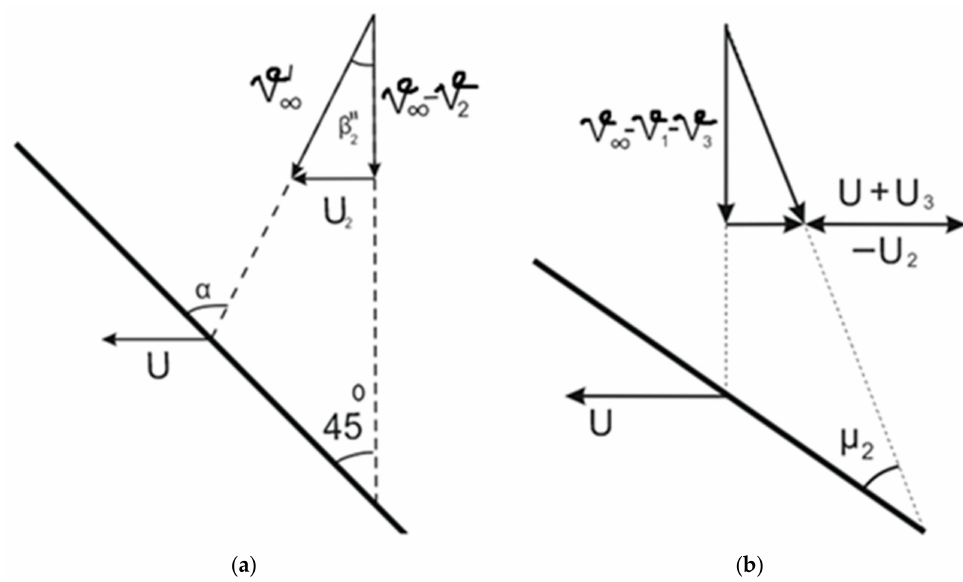
Figure 10. Absolute ( a ) and relative ( b ) velocities of the flow incident on the 2nd plate. The absolute velocity ϑ (cid:48) ∞ is the sum of ϑ − ϑ 2 and U 2 . The angle that it forms with the plate is the angle of attack for the second plate. From Figure 10 it can be seen that α = 45 ◦ + β . In the formulas of C x and C y sin α and cos α appears. We determined these functions using the results of calculations for the first